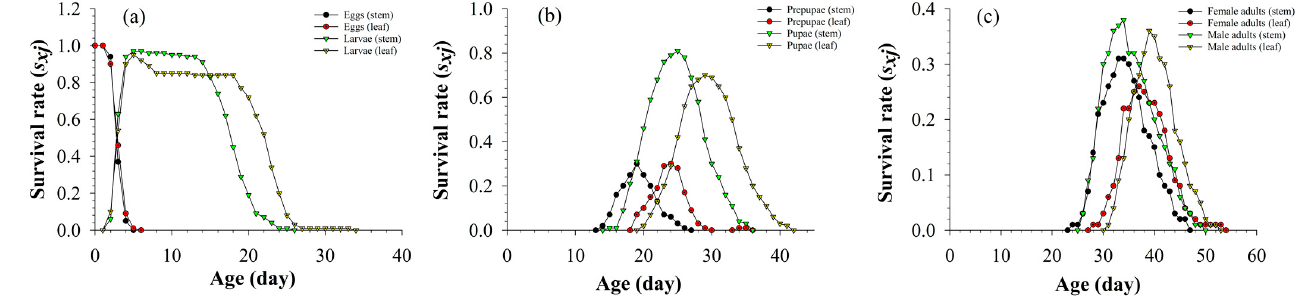
Figure 1. Survival rate of eggs and larvae ( a ), prepupae and pupae ( b ), female adults and male adults ( c ) of S. litura fed on different tissues of asparagus.